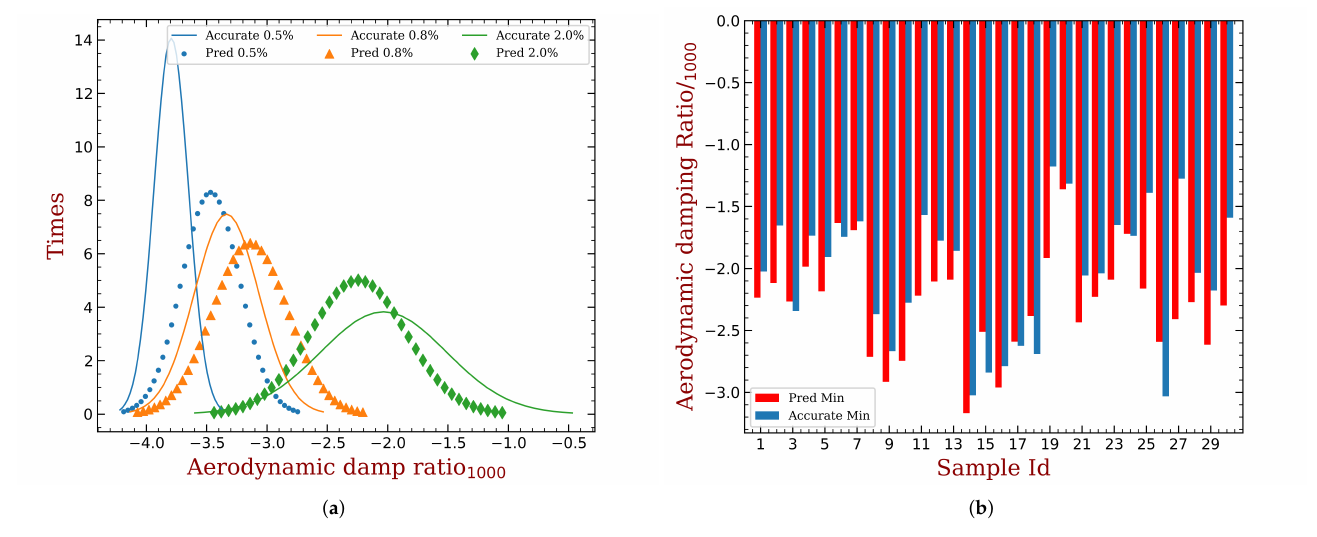
Figure 14. Predicted aerodynamic damping with random patterns of standard deviation 0.5%, 0.8%, and 2%. The results labeled ’Pred Data’ are computed from Equations (31) and (32). ( a ) Frequency graph, ( b ) least aeroelastic damping of 30 samples with standard deviation